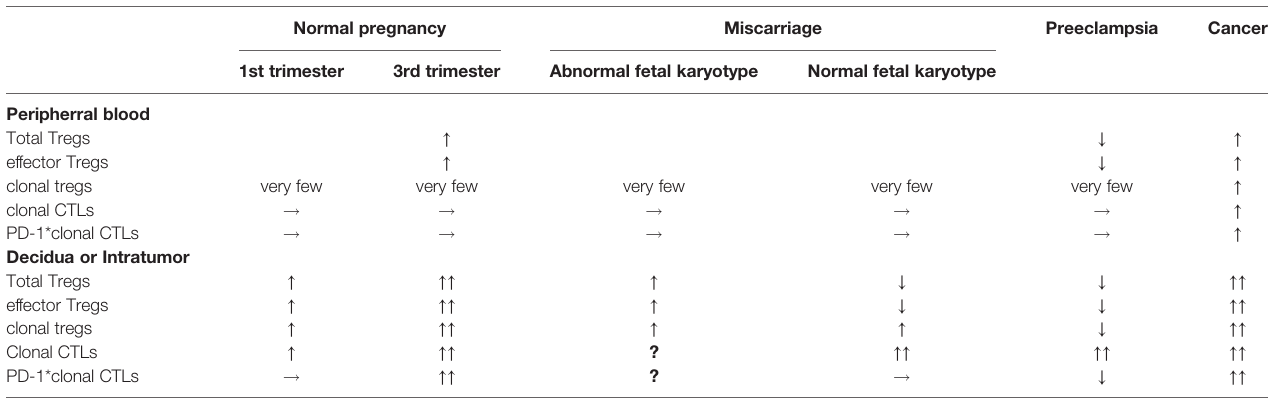
TABLE 1 | Tregs and cytotoxic T cells (CTLs) in normal pregnancy, complicated pregnancy and cancer patient. Normal pregnancy Abnormal fetal